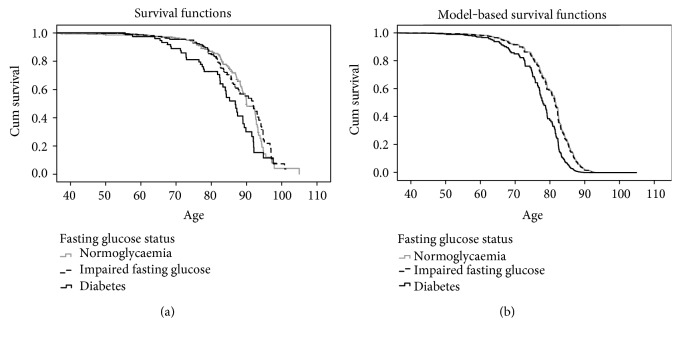
Unadjusted (a) and model adjusted (b) cumulative survival functions for fasting glucose status versus age at death (x-axis). Adjusted model includes fasting plasma glucose, age at cohort entry, and smoking status.